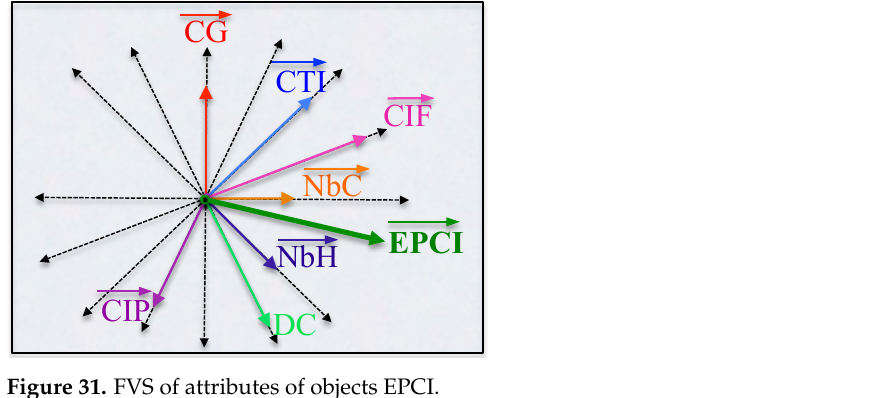
Figure 31. FVS of attributes of objects EPCI.